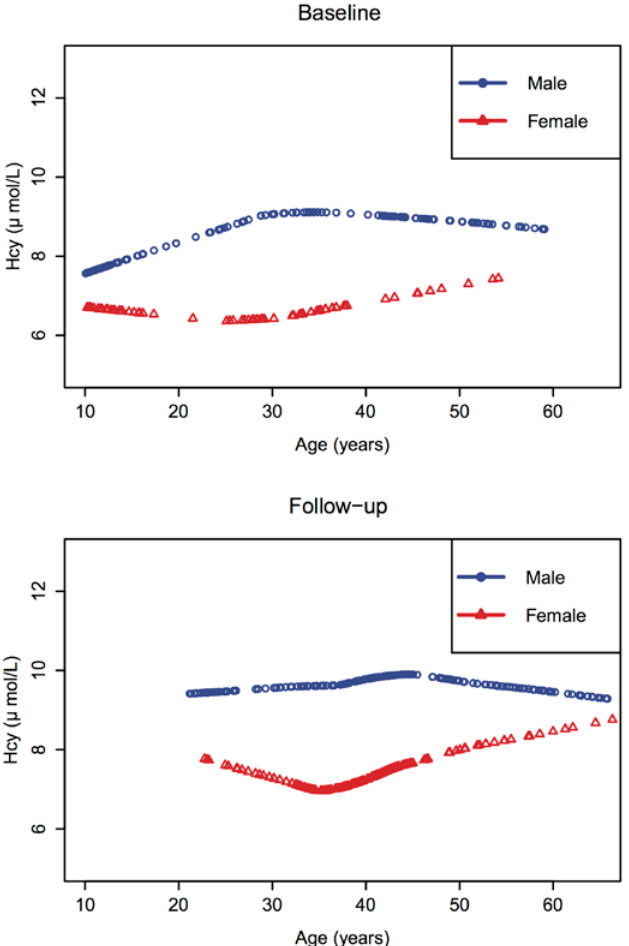
Figure 1. Gender-specific LOESS, a generalized method of locally weighted scatterplot smoothing (LOWESS), smoothing plots of plasma homocysteine across